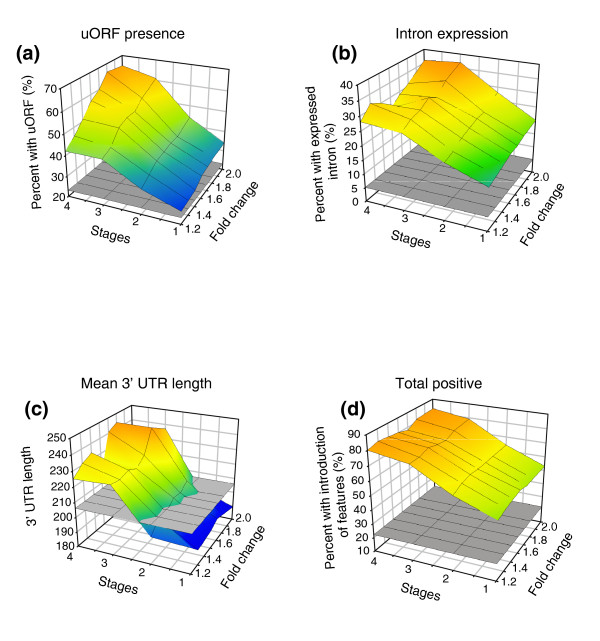
Features predisposing transcripts to NMD. Indicated are the percentage of genes exhibiting the measured feature (y-axis), the number of stages at which this is observed (x-axis) and the fold increase in gene intensity in smg-1(r861) over N2 (z-axis, log2 scale). In each case the average background occurrence of the feature is indicated by the grey square. The measured features are: (a) percentage of genes with a uORF; (b) percentage of genes with expressed introns; (c) average 3' UTR length; (d) the total percentage occurrence of the above three NMD features for the set of over-expressed genes. The plots show a clear positive correlation between the feature examined and the increased effect of NMD on the transcripts.